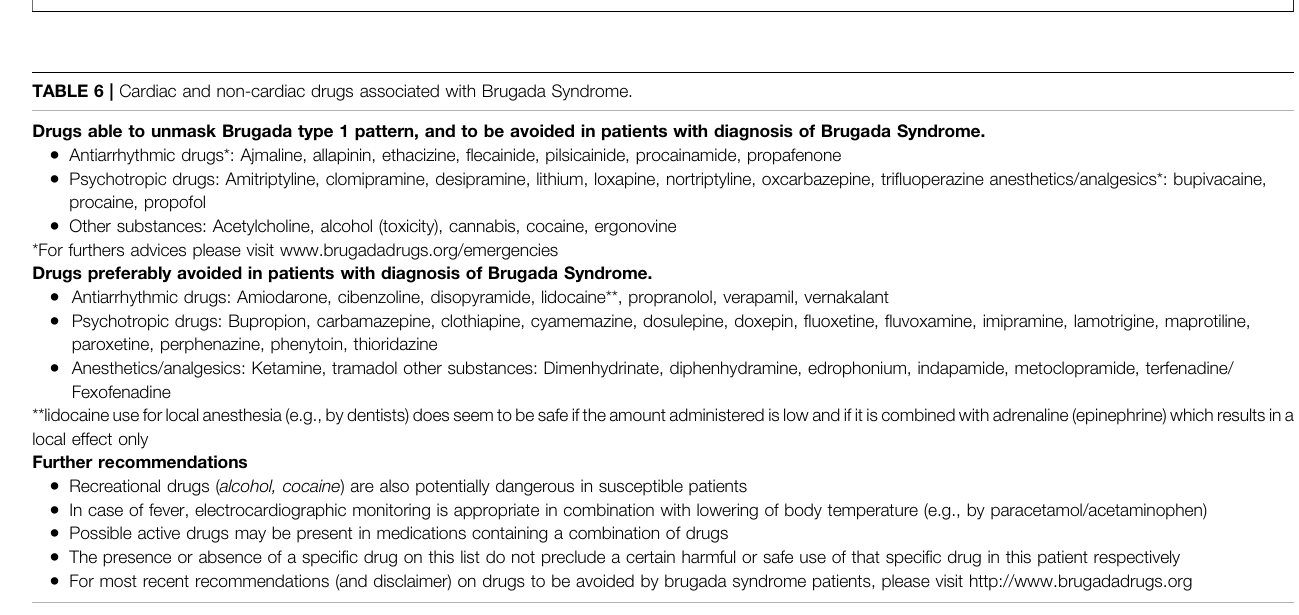
FIGURE 3 | Brugada Pattern and ventricular tachycardia following fl ecainide therapy. Brugada Pattern and ventricular tachycardia following fl ecainide therapy (dosage 100 mg b. i.d) recorder by implantable loop recorder in a male patient (age 48 years) with a history of paroxysmal atrial fi brillation.